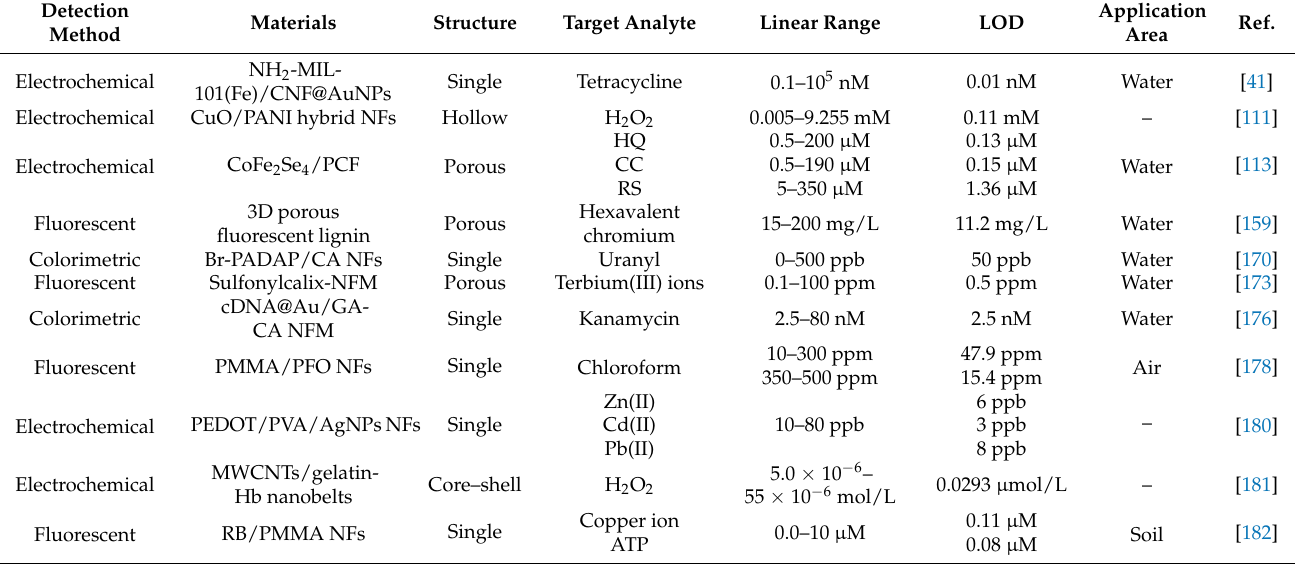
Table 1. Electrospun-NFs-based chemosensors for environmental pollution